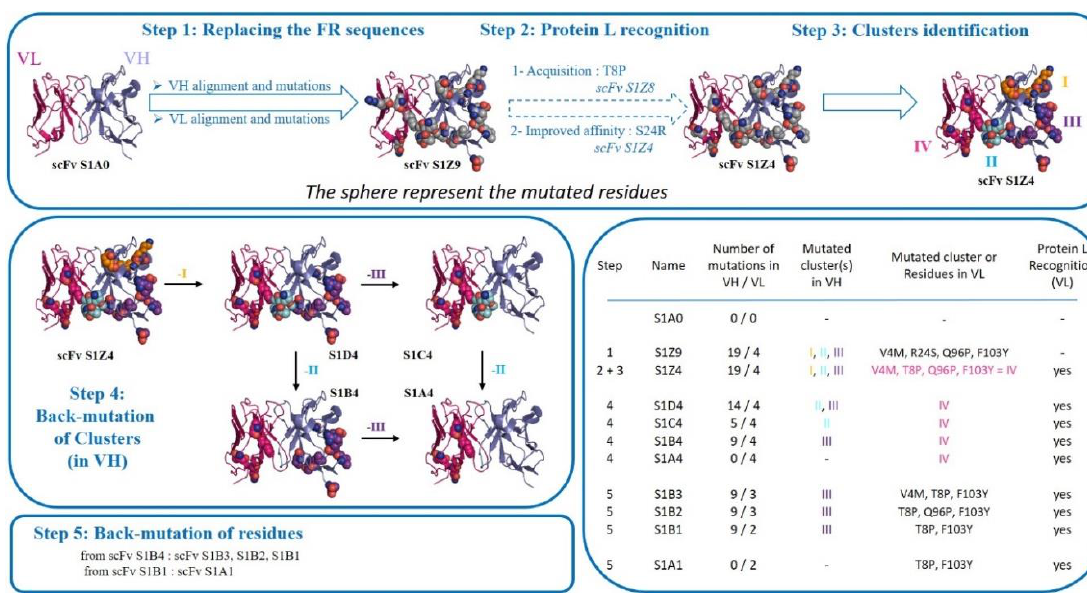
Figure 2. Design of scFvs for the exploration of biophysical properties. Flowchart depicting the stepwise process leading from scFv S1A0 to the creation of all scFvs needed for the exploration of biophysical properties. Ribbon representations of 1YNT structure showing amino acid residue mutations in spheres according mutations of different scFvs. Grey spheres represent mutations after the replacement of FR sequences (step 1) and the method employed to confer Protein L binding ability (step2). Mutations are depicted as divided into four clusters: cluster I, AA close to CDRs (orange)—cluster II, AA connecting C-C’ strands (blue)—cluster III, all other AA on the VH domain (purple) and cluster IV, AA on the VL domain (pink). Additional information regarding each one of the scFv constructs was indicated in the table, at the lower right.